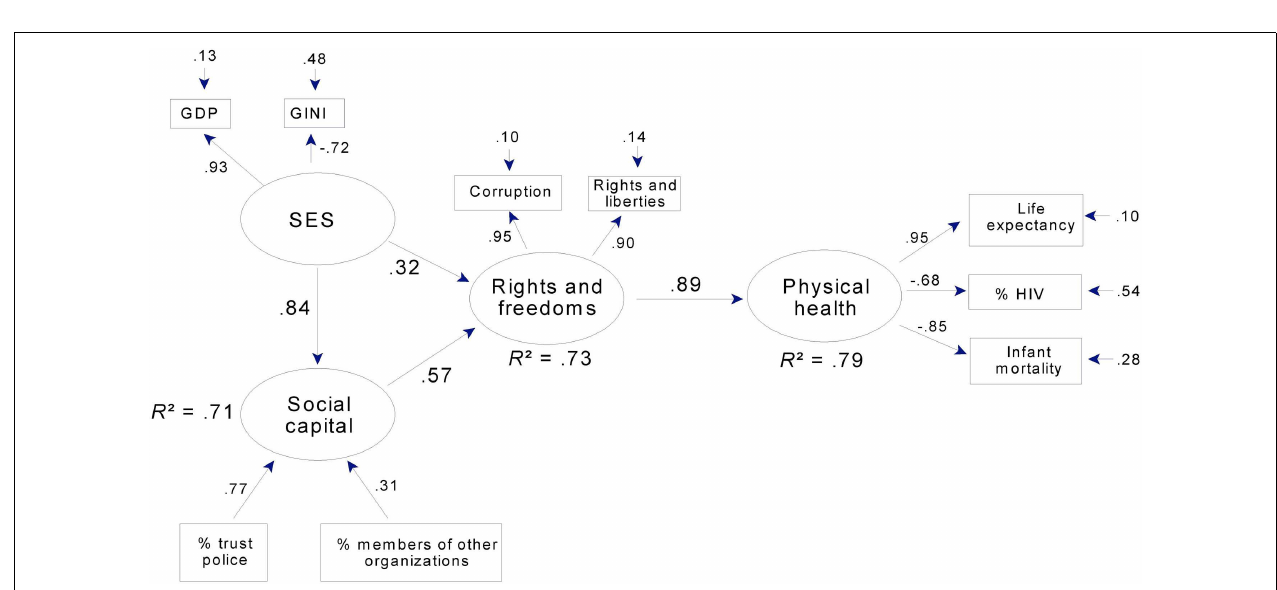
FIGURE 6 | Physical health, SES, and rights and freedoms: a path model for 34 countries. Note that corruption is reverse-scored, so that high scores = low levels of corruption. Rights and liberties = mean